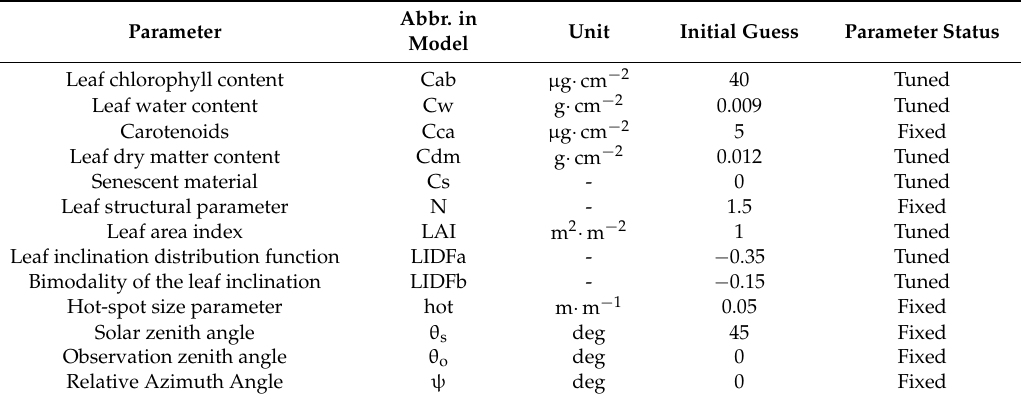
Table 2. Initial guess of parameters for retrieval and their status in the model inversion.